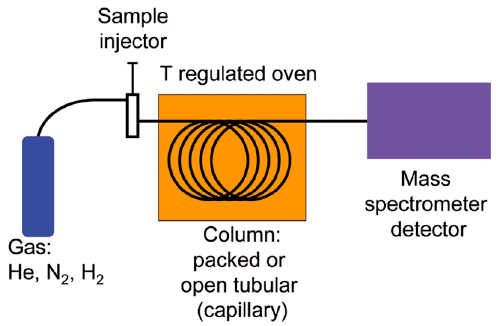
Figure 2. Schematization of a GC-MS (gas chromatography coupled with mass spectrometry) analysis system.